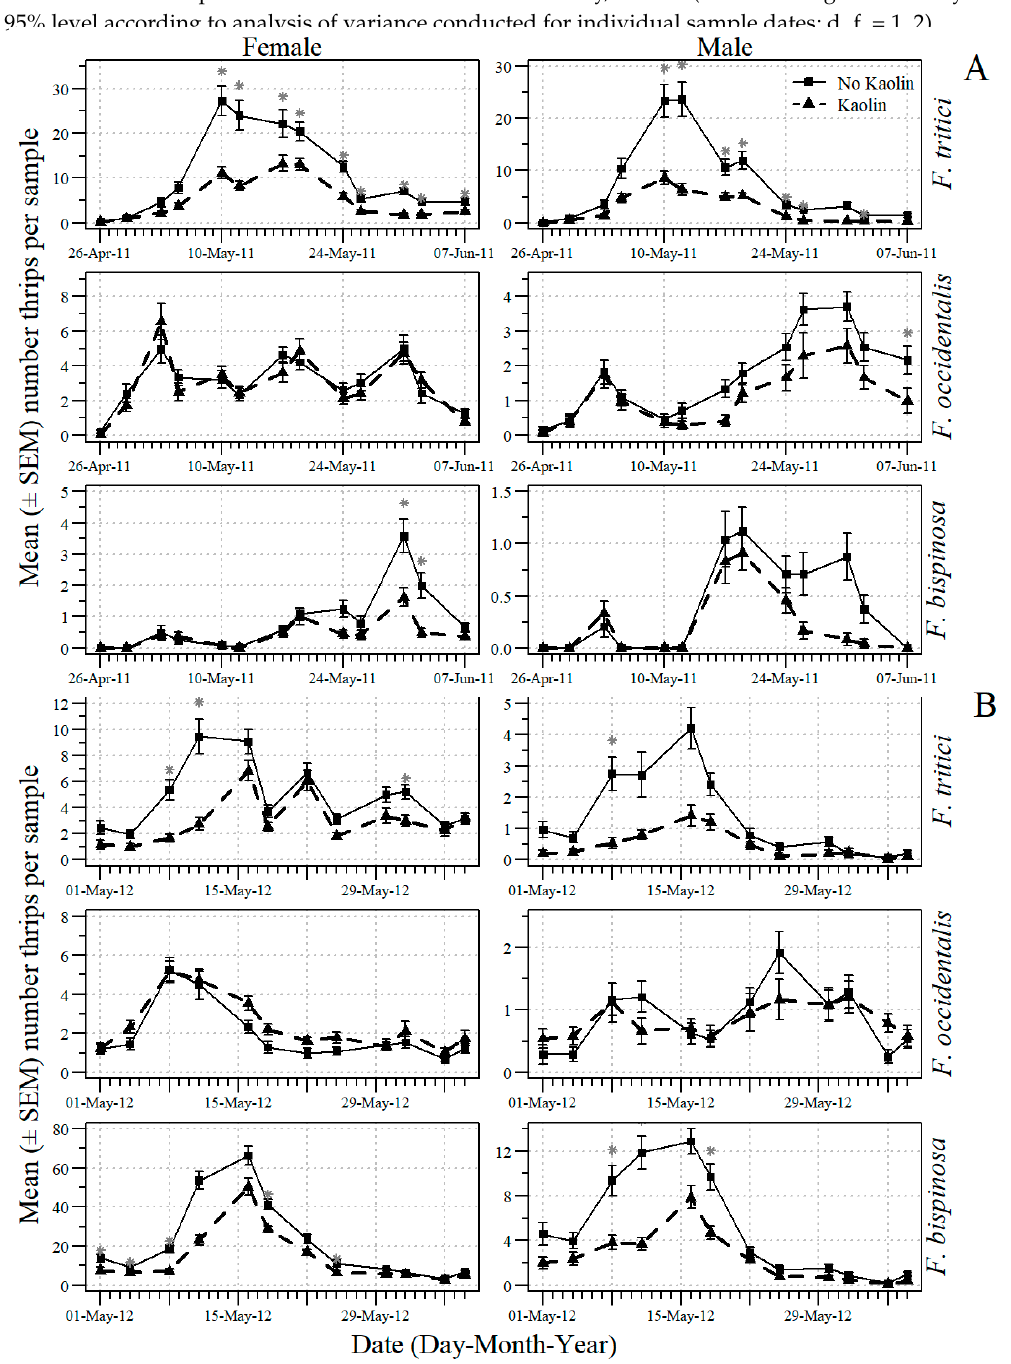
Figure 2. The mean number (+SEM) per 10 tomato flowers (n = 12 samples) of adult male and female F. occidentalis , F. bispinosa and F. tritici on each 2011 ( A ) and 2012 ( B ) sample date in the sub-plot treatments of no kaolin and kaolin for data pooled across companion plant treatments in the experiments conducted in Gadsden County, Florida (* indicates significance beyond 95% level according to analysis of variance conducted for individual sample dates; d. f. = 1,